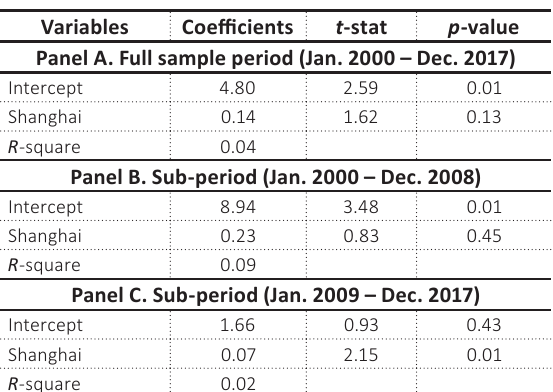
Table 7. Regressions of ROE on annual